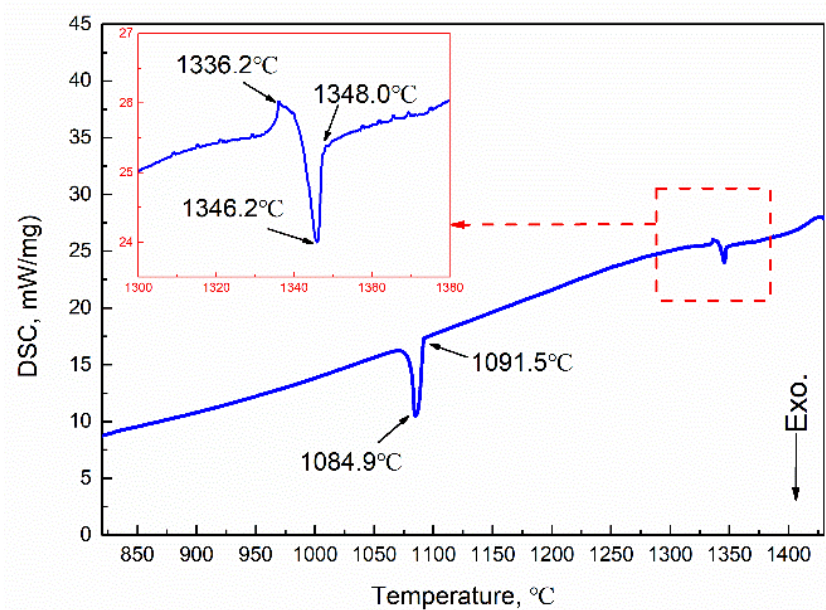
Figure 3. DSC curve at a cooling rate of 20 °C/min.